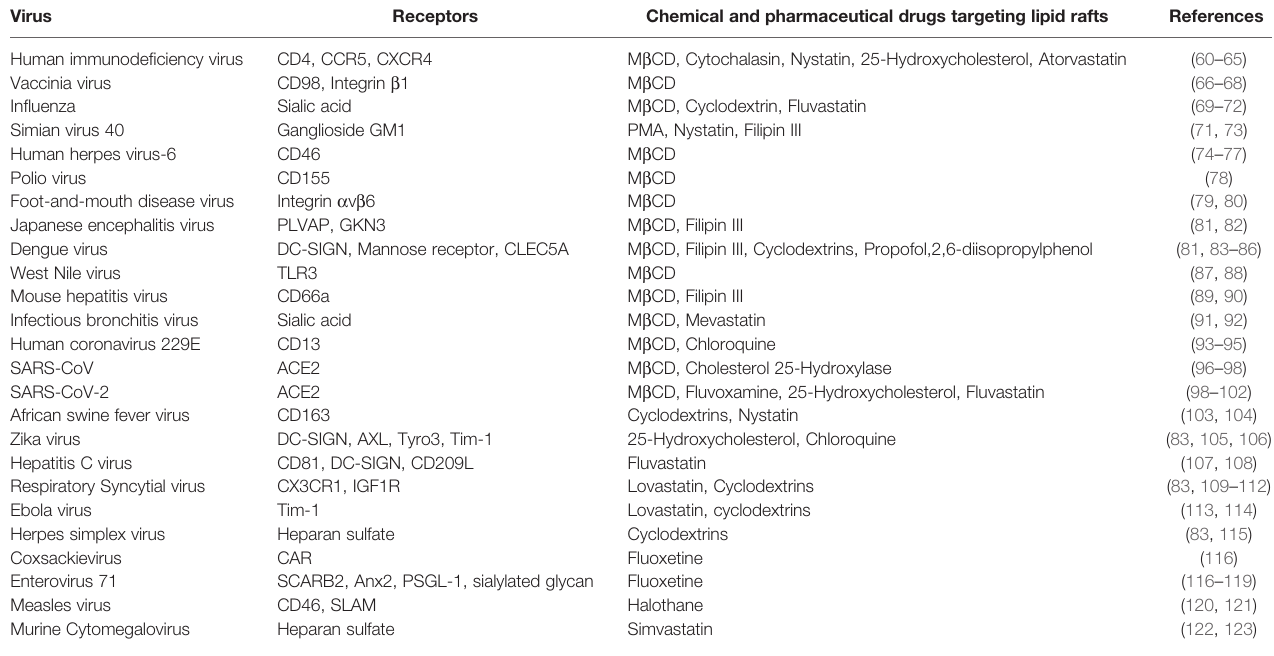
TABLE 1 | Lipid raft mediated viral entry and receptors